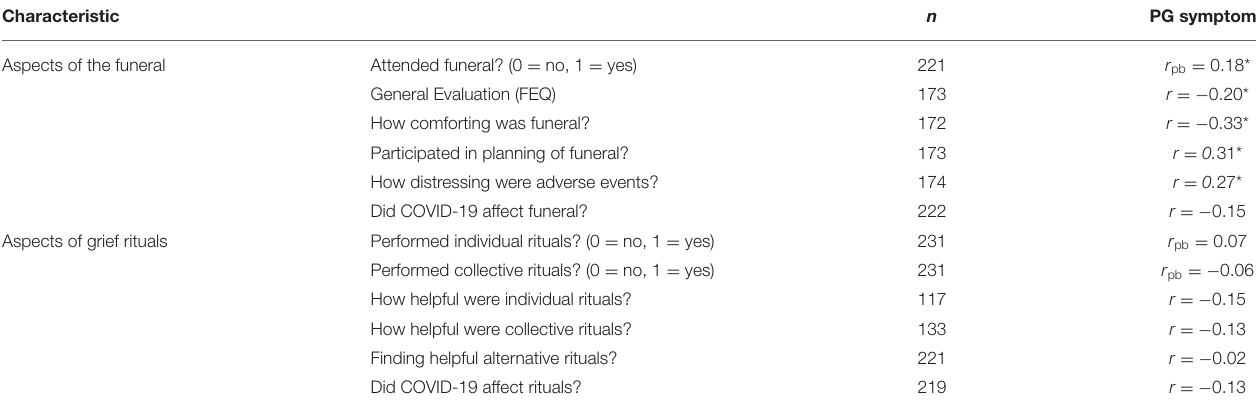
TABLE 3 | Pearson correlations and point biserial correlations between aspects of the funeral service, grief rituals and PG symptoms.